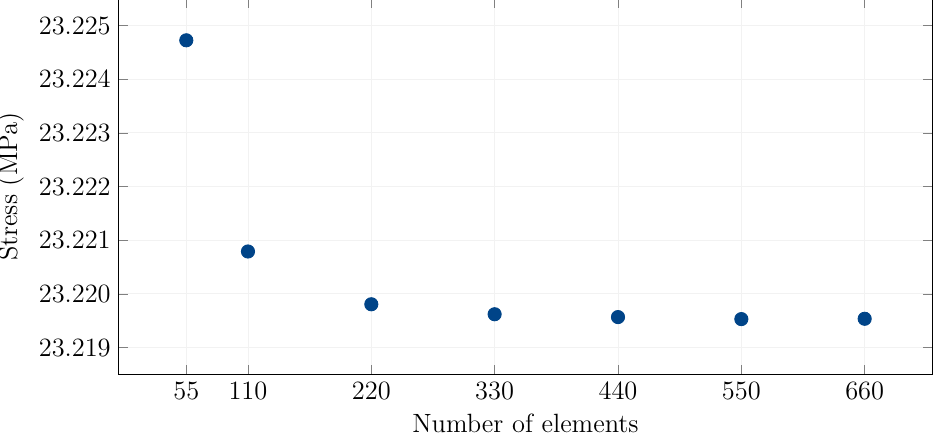
Figure 3. An example of a convergence test for the 7 layer configuration, bottom surface stress, center of the span.